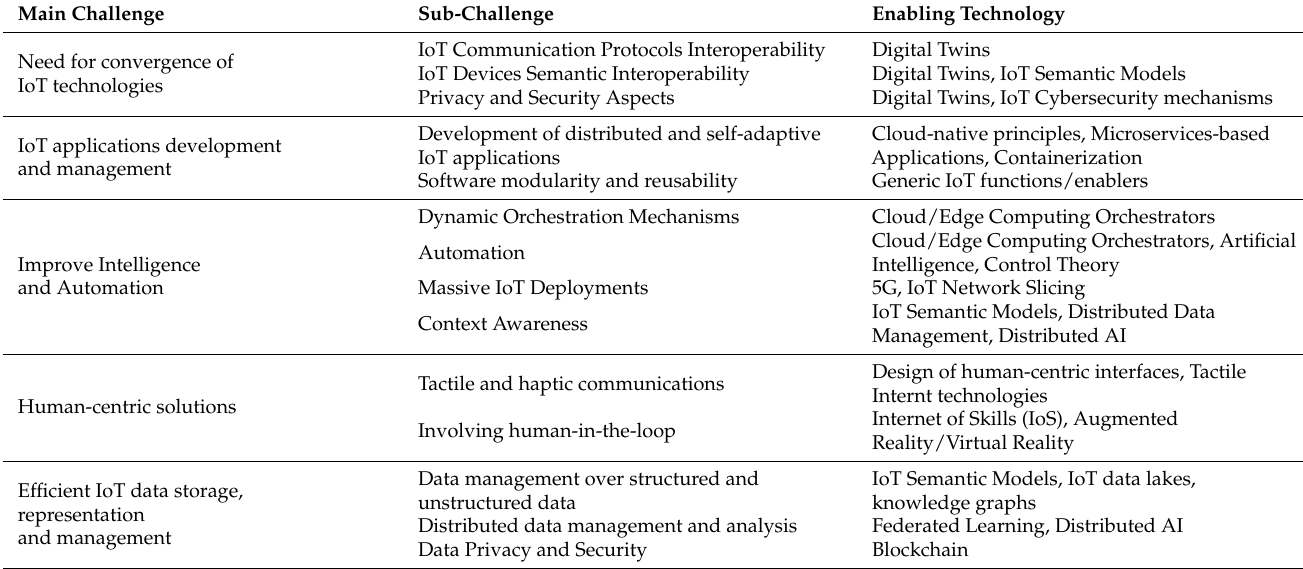
Table 1. The mapping of challenges to enabling